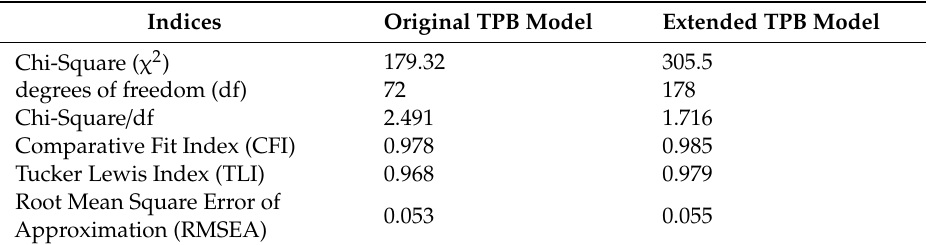
Table 4. General theoretical model-fit